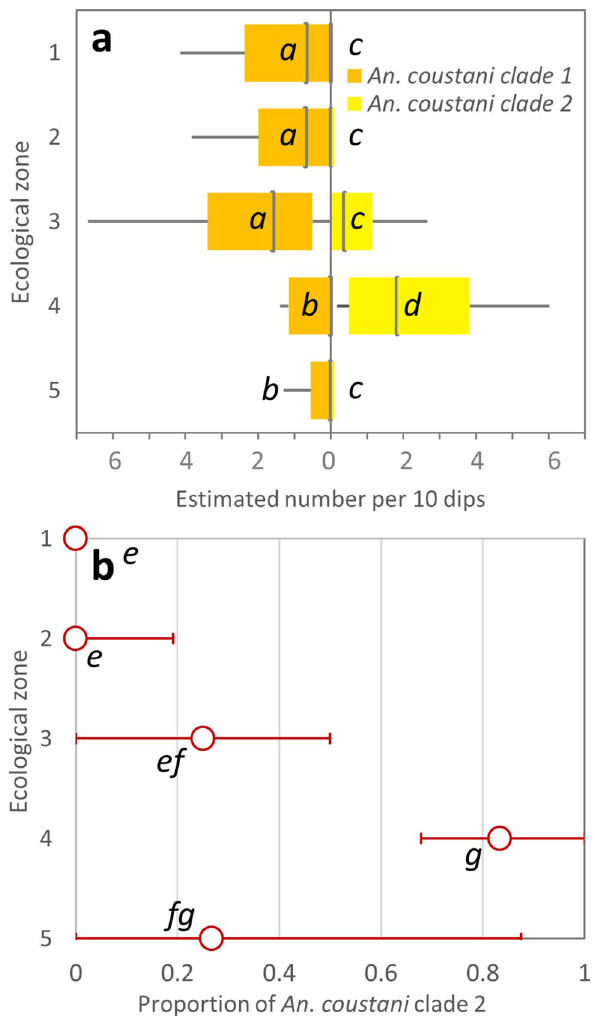
Figure 6. Composition of An. coustani clade 1 and clade 2 larval populations in western Zambia, 2019. ( a ) Abundance of clade across ecological zones. Boxplot represents interquartile range and median (vertical line) estimated total of each clade per 10 dips; whiskers extend to minimum and maximum values within 1.5 × IQR. Ecological zones as per Fig. 1. ( b) Median proportion of clade 2 in An. coustani specimens. Calculated for all transect points where at least one clade present ( n = 128); median proportion indicated by circles, using secondary axis; whiskers indicate IQR. Ecological zones not sharing a letter within two separate comparisons in ( a ) (LHS and RHS) and in ( b ) are significantly different; independent samples median test; stepwise step-down comparisons with adj p < 0.001.